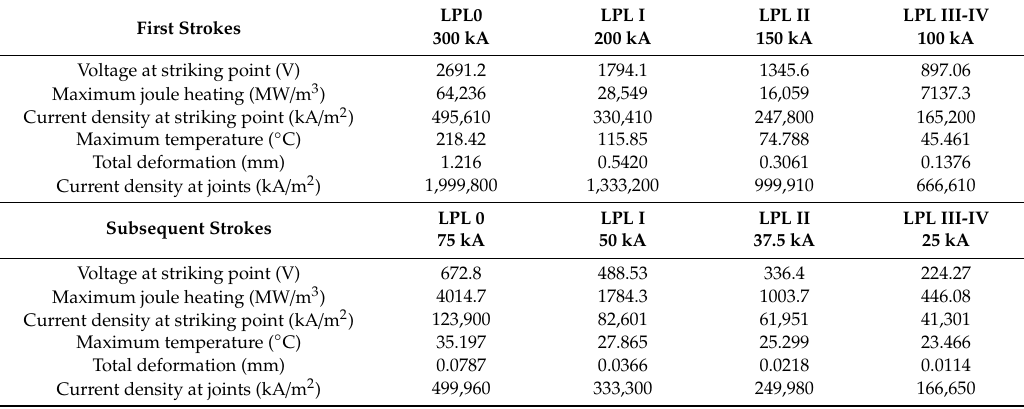
Table 7. Results obtained from the first and subsequent return strokes for Case Study